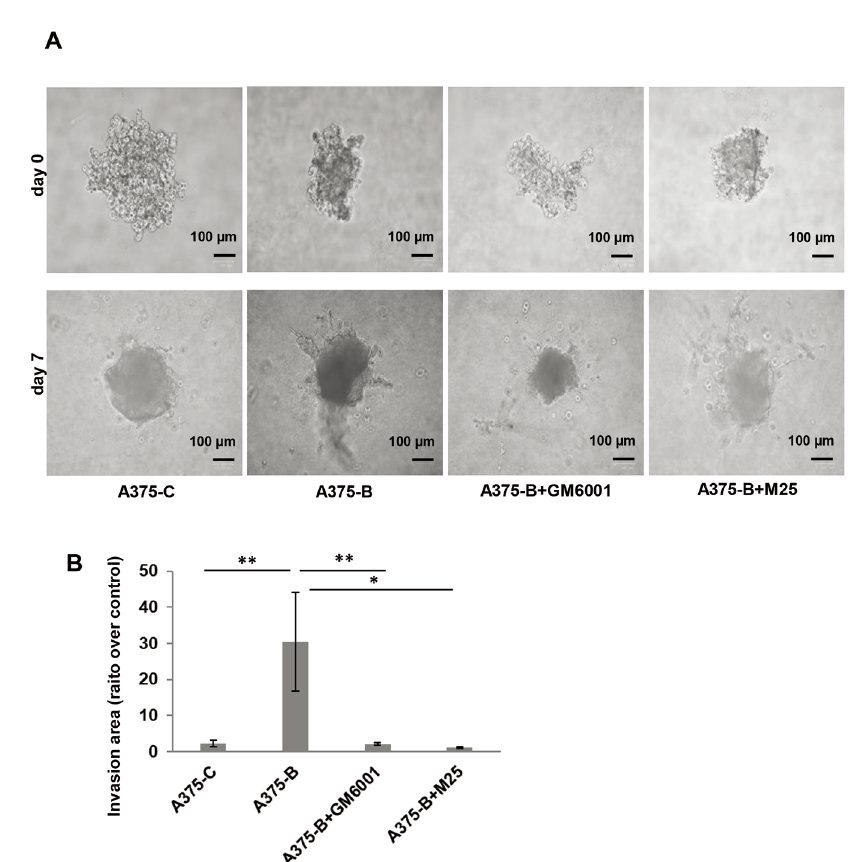
Figure 5. Bcl2L10 enhances the ability of melanoma cells to invade. (A) Representative images of 3D spheroid invasion assays using A375 cells transfected with empty (A375-C) or Bcl2L10 (A375-B) expressing vectors over 7 days following the addition of invasion matrix, and A375-B cells treated with matrix metalloproteinases (MMPs) inhibitor (Ilomastat/GM6001) or uPAR inhibitor (peptide M25). (B) Histograms, quantification of 3D invasion relative to invasion area. Data were expressed as mean ± standard error of the mean. Statistical analysis was performed applying one-way analysis of variance, Tukey post-hoc analysis. * P < 0.05; ** P <